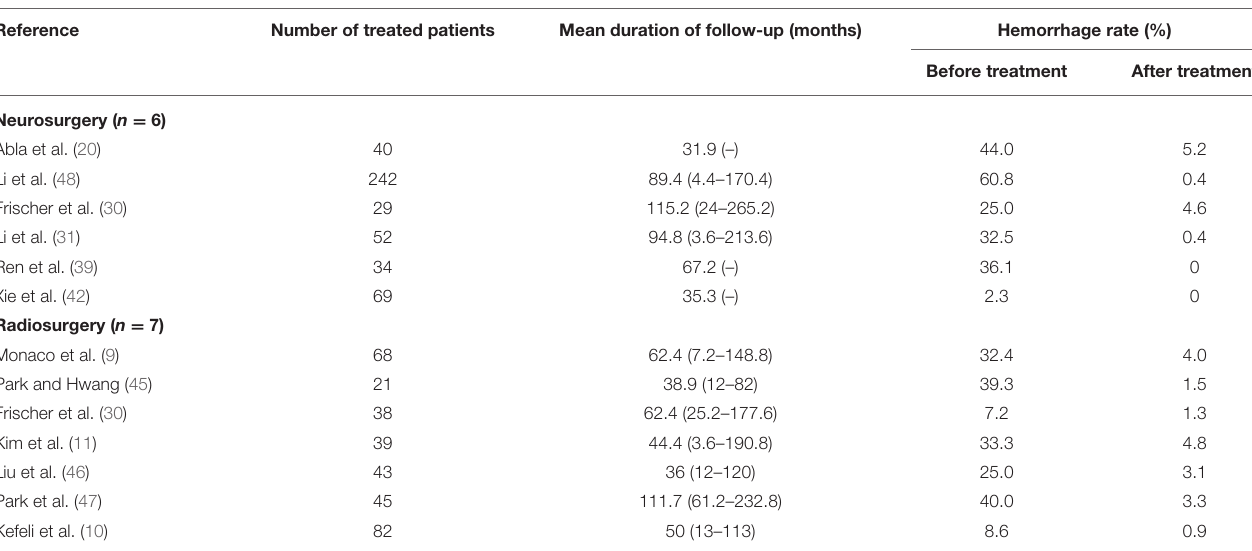
TABLE 3 | Reported risk of hemorrhage in 13 included